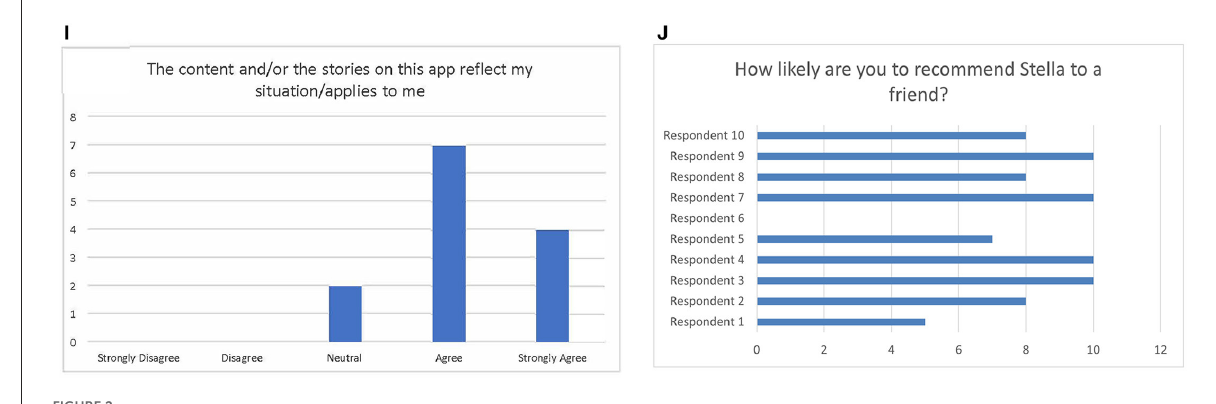
FIGURE2 (A–J) Results of the acceptability